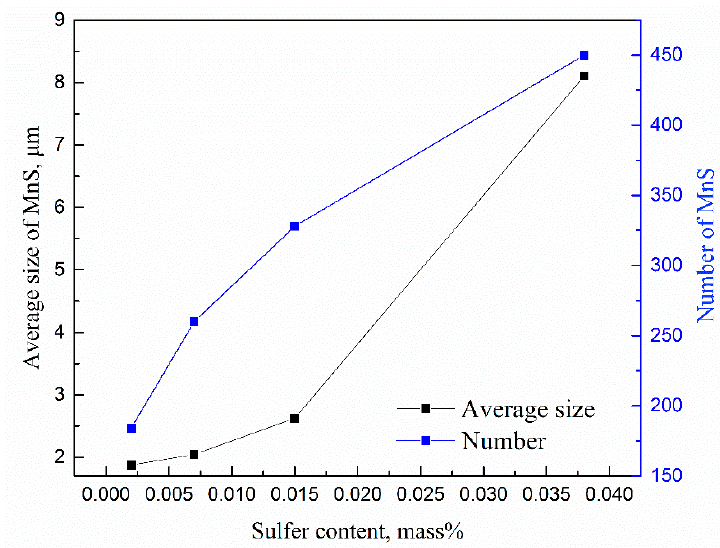
Figure 5. Changes in the average size (left y-axis) and number (right y-axis) of MnS inclusions with the S content.